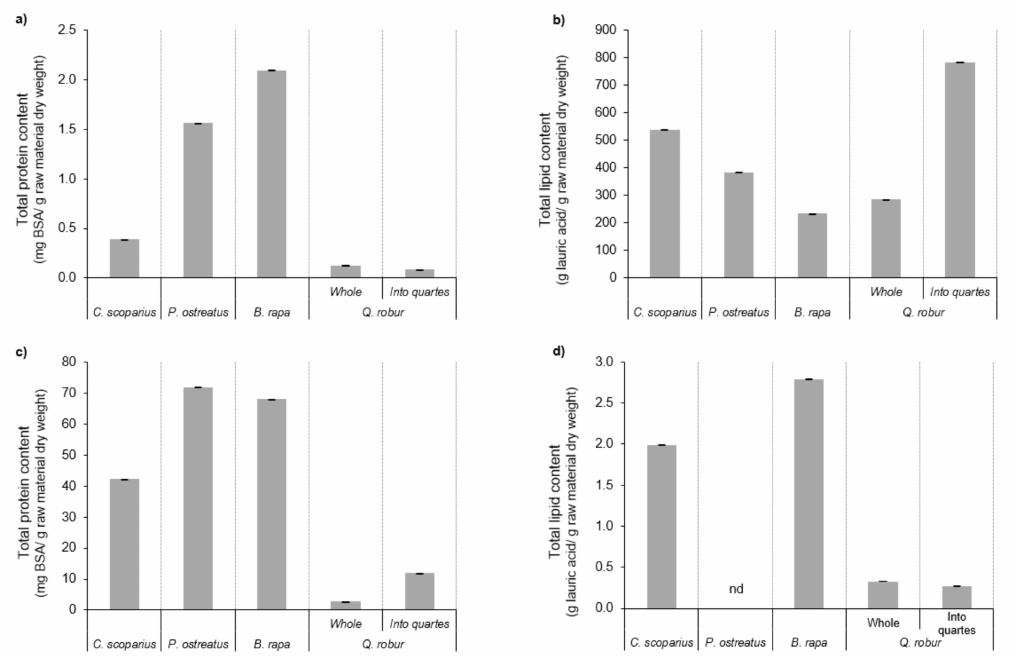
Figure 5. Total protein content ( a , c ) and total lipid content ( b , d ) from the collected aqueous extracts of the di ff erent took in consideration raw materials at 100 W by MHG extraction and from the SLE ethanolic extracts, respectively, from di ff erent raw materials. nd: no